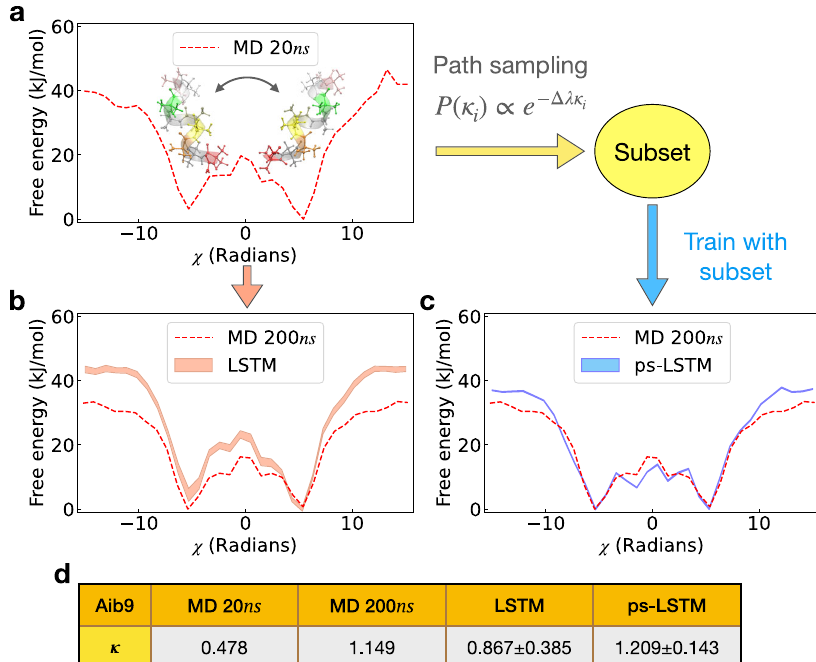
Fig. 3 | Comparing predictions at 200 ns for different values of the symmetry parameter κ . Here we show that ps-LSTM learns the correct symmetry κ . The original training data is a 20 ns Aib9 trajectory generated from MD simulation at 500K, where ( a ) shows its calculated free energy pro fi le has an asymmetry of populationbetweenLandRhelixstates.ThesnapshotsofLandRcon fi gurationsat χ =5.2 and χ = − 5.31 are also displayed as insets above the free energy pro fi le. TrainingLSTMmodelwiththisasymmetricdataand usingittopredictwhatwould happenat200 ns leadstotheresultshownin( b ),wheretheLSTMpredictionsretain and even enhance the undesired free energy asymmetry while the free energies